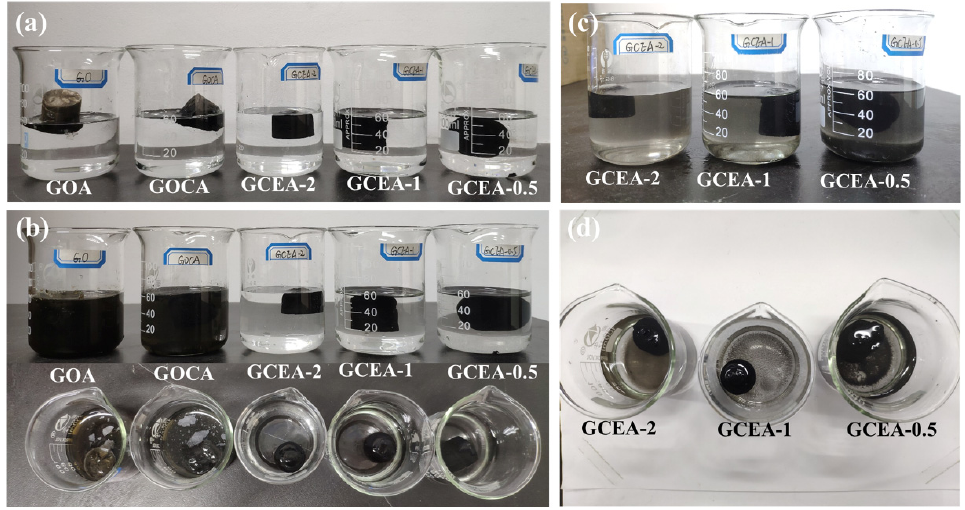
Figure 5. The digital images of GOA, GOCA, and GCEA immersed in water, ( a ) 0 min, ( b ) ultrasonic treatment for 1 min (side and top view), ( c , d ) the GCEA in ultrasonic treatment for 30 min (Color figure can be viewed online).